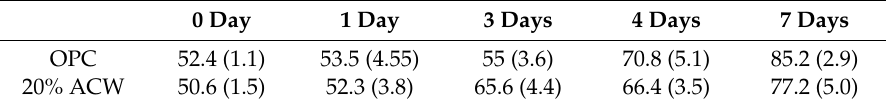
Table 7. Compressive strength (MPa) in 0–7 days carbonated cement pastes.